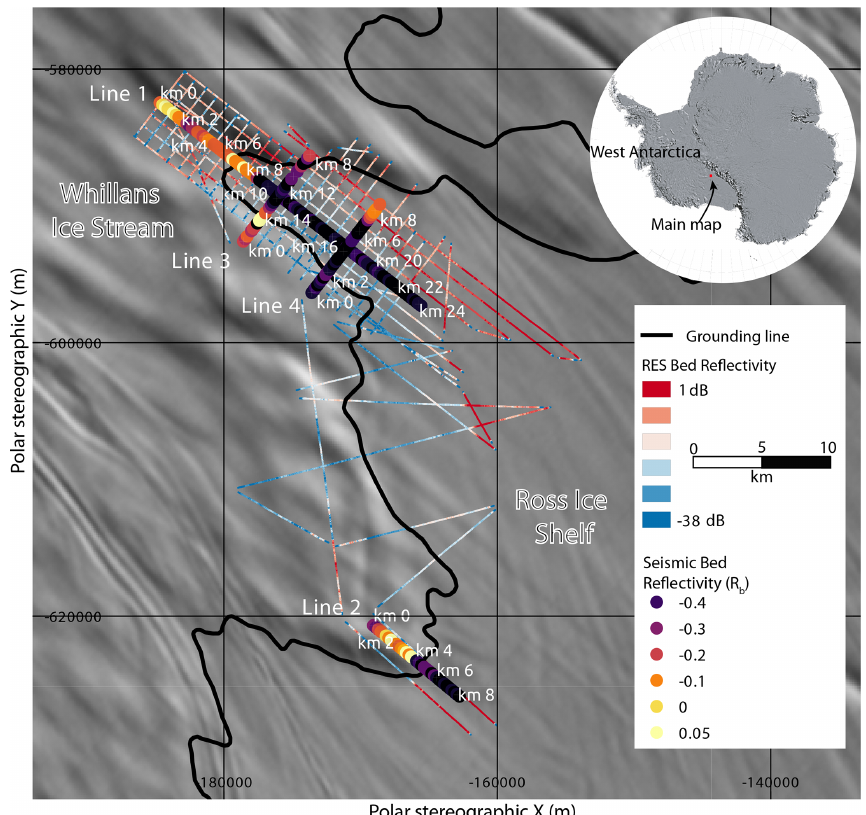
Figure 1. Location map showing the seismic profiles (lines 1–4) crossing the grounding zone of Whillans Ice Stream. Radio echo sounding (RES) basal reflectivity from Christianson et al. (2016). Seismic bed reflectivity ( R b ) from this study. Background imagery from MODIS MOA (Haran et al., 2005) and grounding line from Bindschadler et al. (2011). Polar stereographic projection (metres) with a true scale at 71 ◦